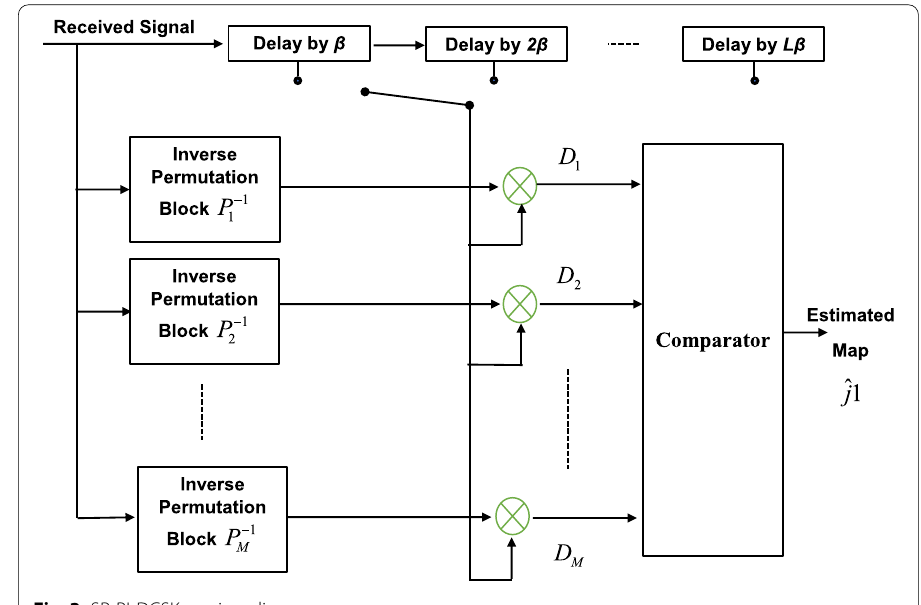
Fig. 3 SR‑PI‑DCSK receiver